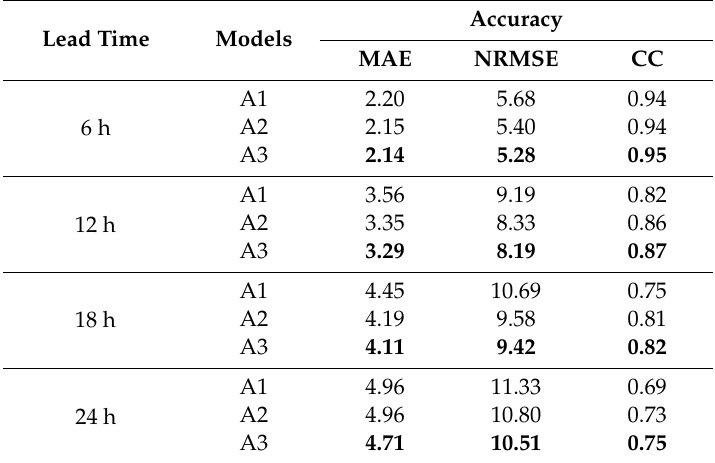
Table 7. Errors of the TC intensity at 6, 12, 18, and 24 h lead